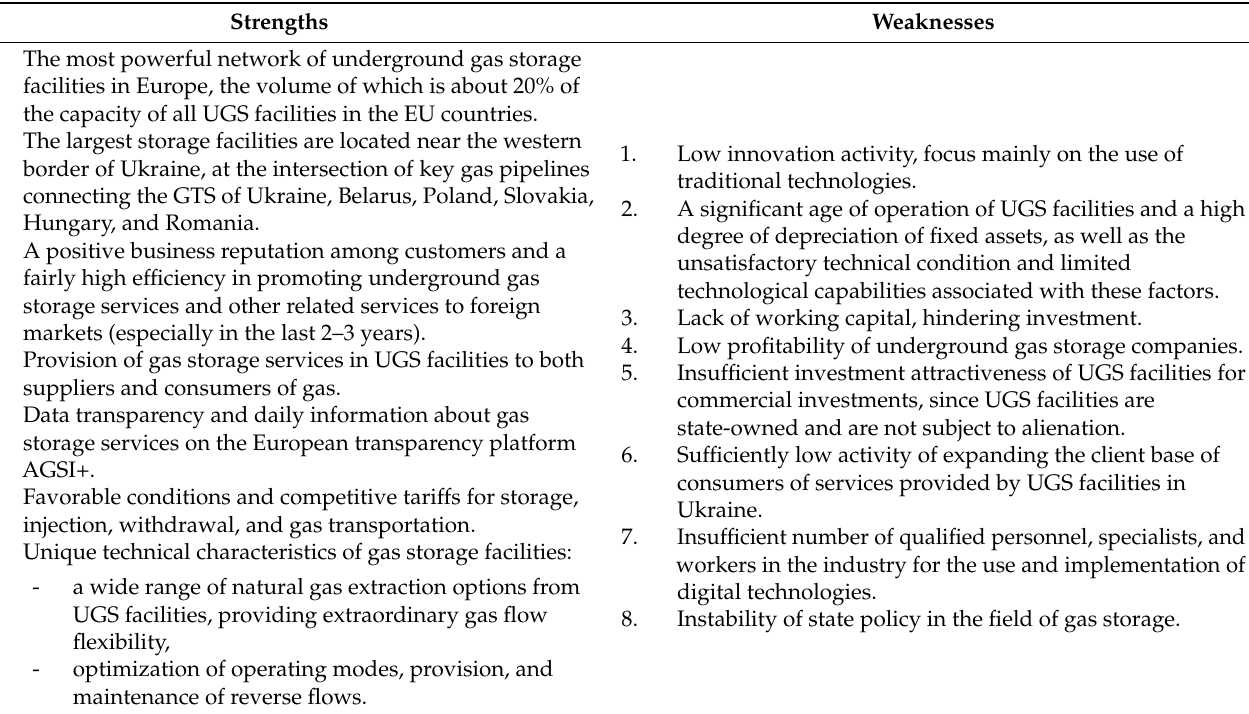
Table 8. Matrix of SWOT analysis of the prospects for using UGS facilities in Ukraine. Strengths